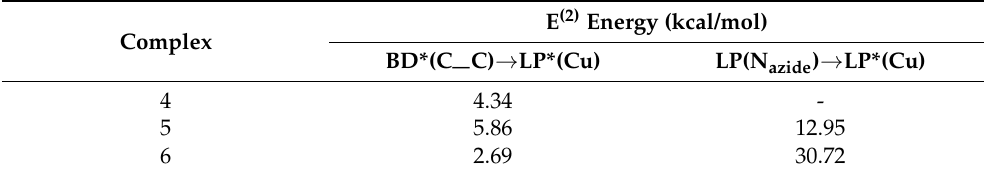
Table 4. NBO analysis for the intermediate complexes in the CuAAC